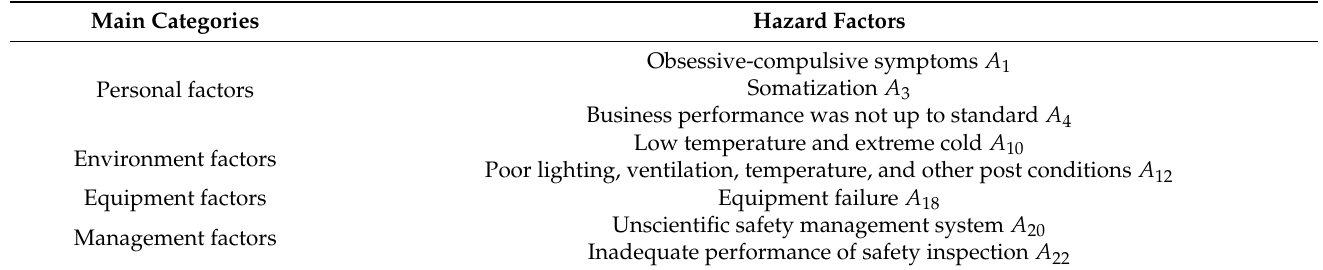
Table 7. Hazard factors of “the assistant watchman did not appear as